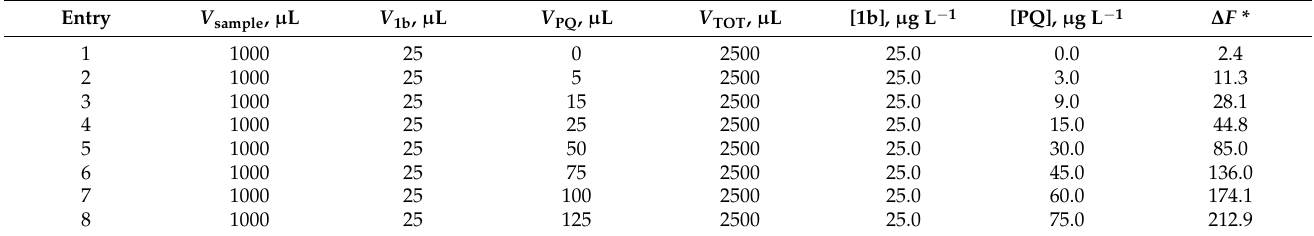
* The fluorescence change ∆ F = F 0 − F was calculated with respect to the F 0 value measured in a non-spiked water sample obtained as in entry 1, but from ultrapure, HPLC-grade water. The fluorescence values were measured at 416 nm for anthracene fluorophore 1b. ∆ F was calculated as an average value of three independent determinations. Table 9. Experimental data for the standard additions plot reported in Figure 12. V 1b and V DQ are the added volumes of the standard methanol solutions of [1b] = 2500 µ g L − 1 and [DQ] = 1500 µ g L − 1 , respectively. A tap water sample was spiked and divided into 8 aliquots. The spike concentration of 1.0 µ g L − 1 was normalized to the total volume of 2500 µ L, 60/40